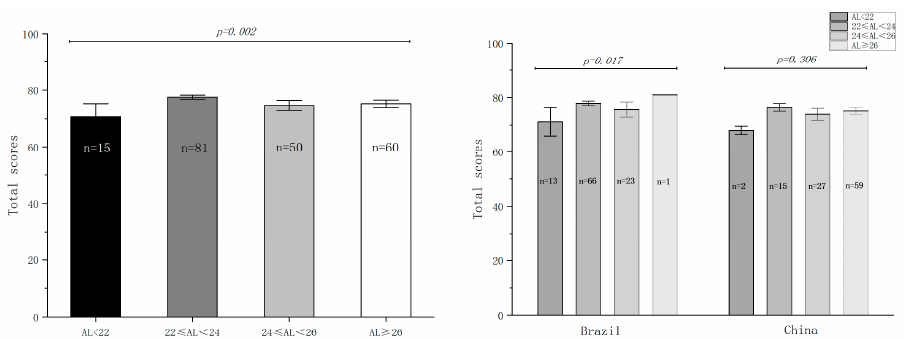
Figure 4. Comparison of total scores between AL groups.